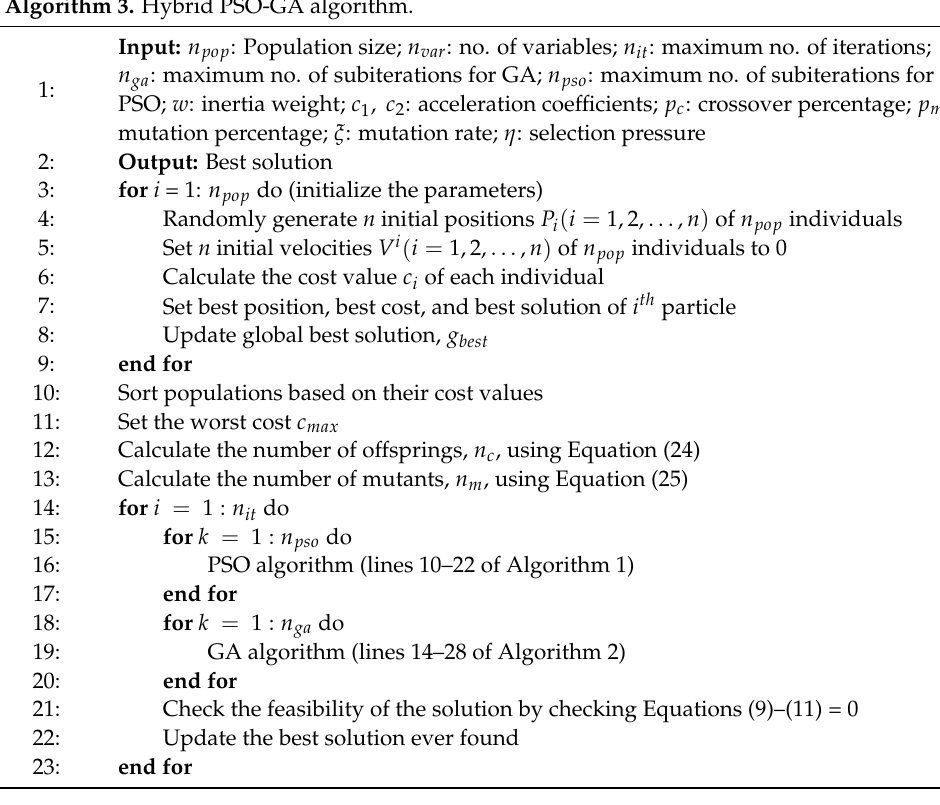
Algorithm 3. Hybrid PSO-GA algorithm.